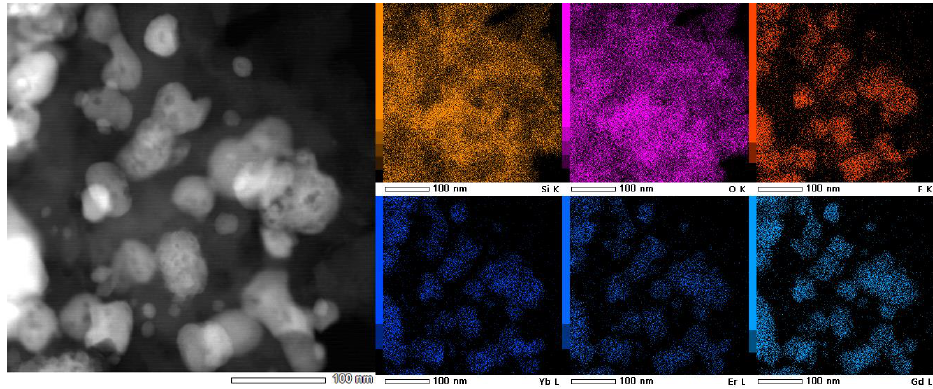
Figure 4. STEM images of the Yb 3+ /Er 3+ -doped SiO 2 -GdF 3 /LiGdF 4 nano-glass ceramic (2LiGC) and the corresponding EDS mapping.